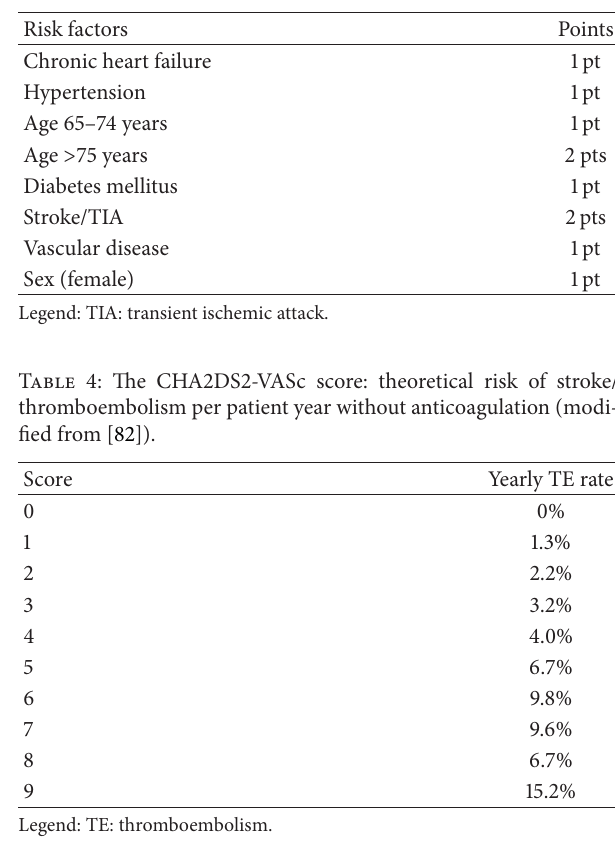
Table 3: The CHA2DS2-VASc score: pointing system (modified from [82]).